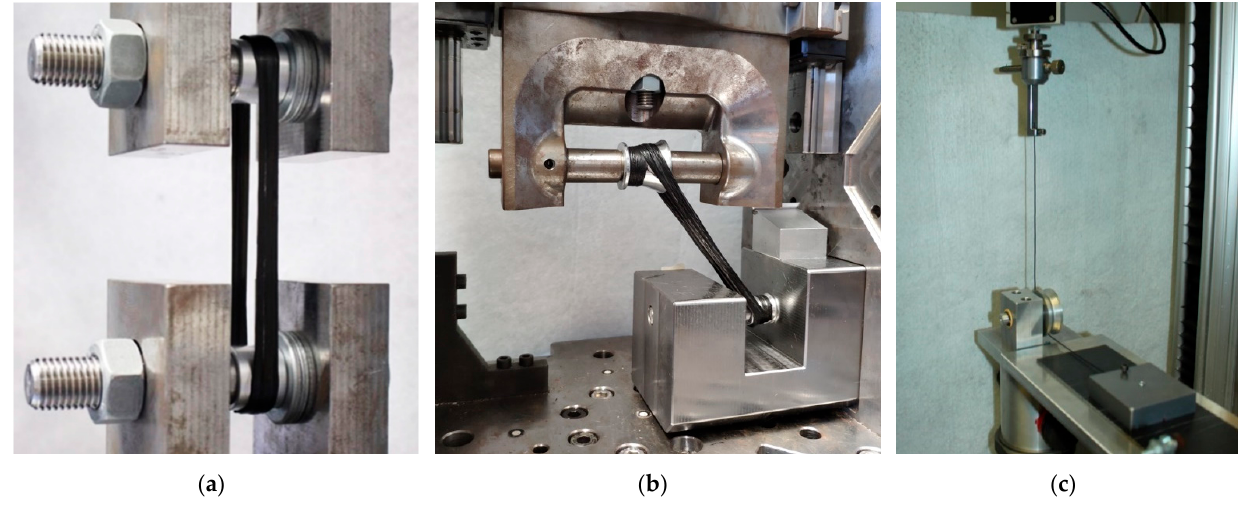
Figure 4. Test setups. ( a ) Simple loop, test setup according to [21]; ( b ) Inclined loop; ( c ) Friction test.